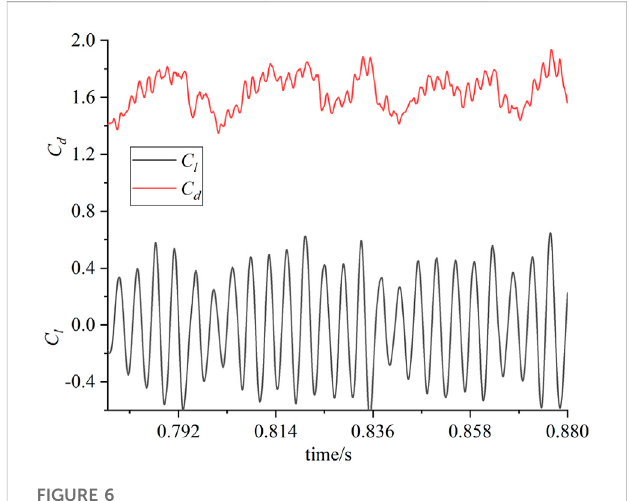
FIGURE 6 Time histories of lift and drag coef fi